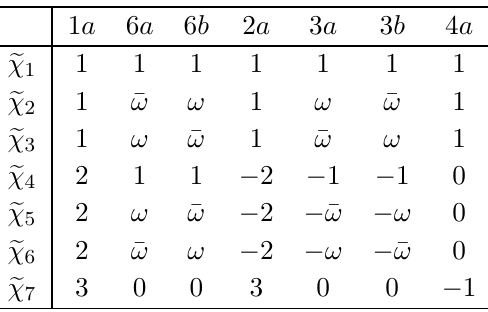
Table 2 . Character table of SL(2 , Z 3 ) . T is in conjugacy class 3 b , while T 2 is in the conjugacy class 3 a